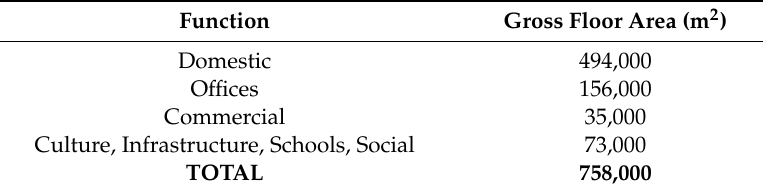
Table 3. Building use in the “Nordwestbahnhof“ development area based on Ref.